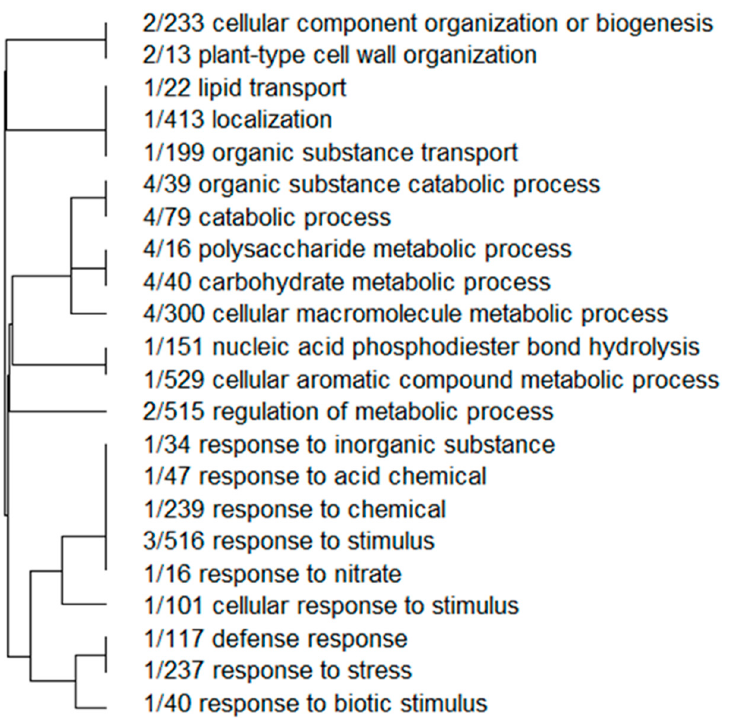
Figure 3. Predicted endogenous target clustering of the selected V. nonalfalfae gene models by their biological process according to enriched gene ontologies; the values represent the number of se- lected milRNA targets in each enriched GO annotation.